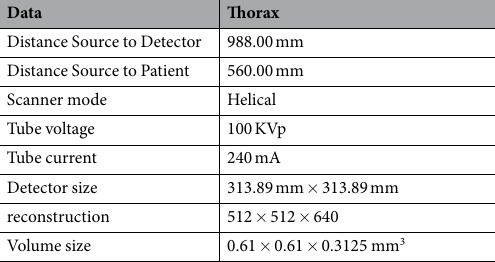
Table 2. acquisition parameters of the experimental